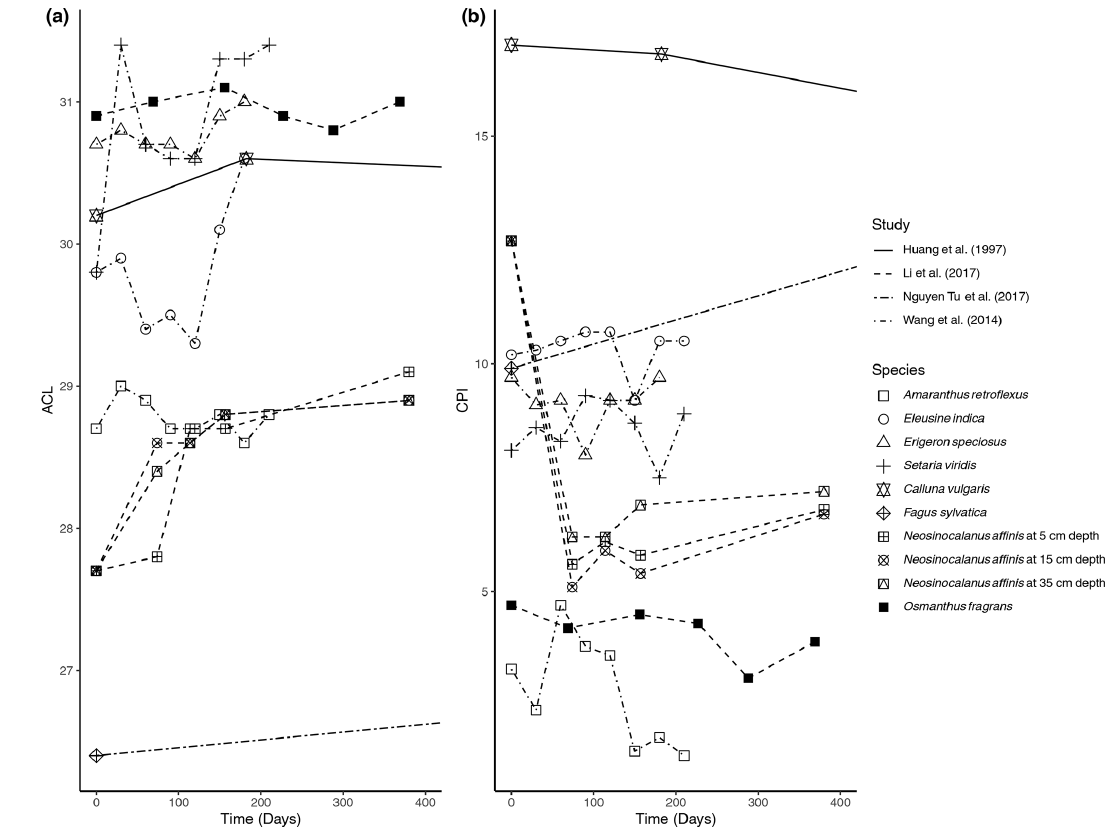
Figure 2. Change in (a) average chain length (ACL) and (b) carbon preference index (CPI) over time in litterbag experiments.